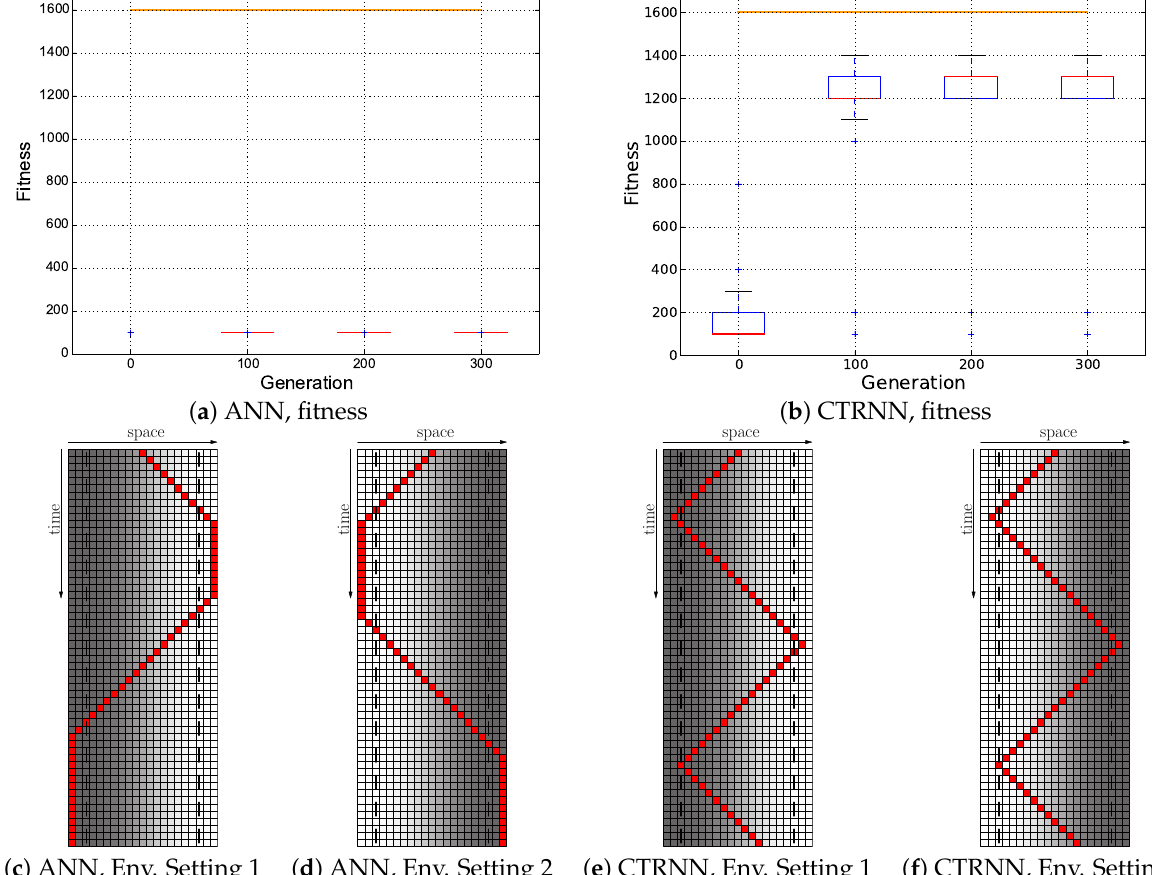
Figure 10. Evolutionary results of the Instant + Switch fitness regime: fitness = F ( 100,0,0.01 ) ; the minimum of both evaluations was used as the fitness value for each genome. Top row: fitness dynamics of the ANNs (left) and CTRNNs (right). The horizontal orange line indicates the maximum fitness achievable by a reactive Wankelmut controller, as it was achieved by the simple hand-coded controller. Bottom row: trajectory of the best performing genome of both controller types in both environments used in evolution (only the initial 56 time steps of 250 time steps are